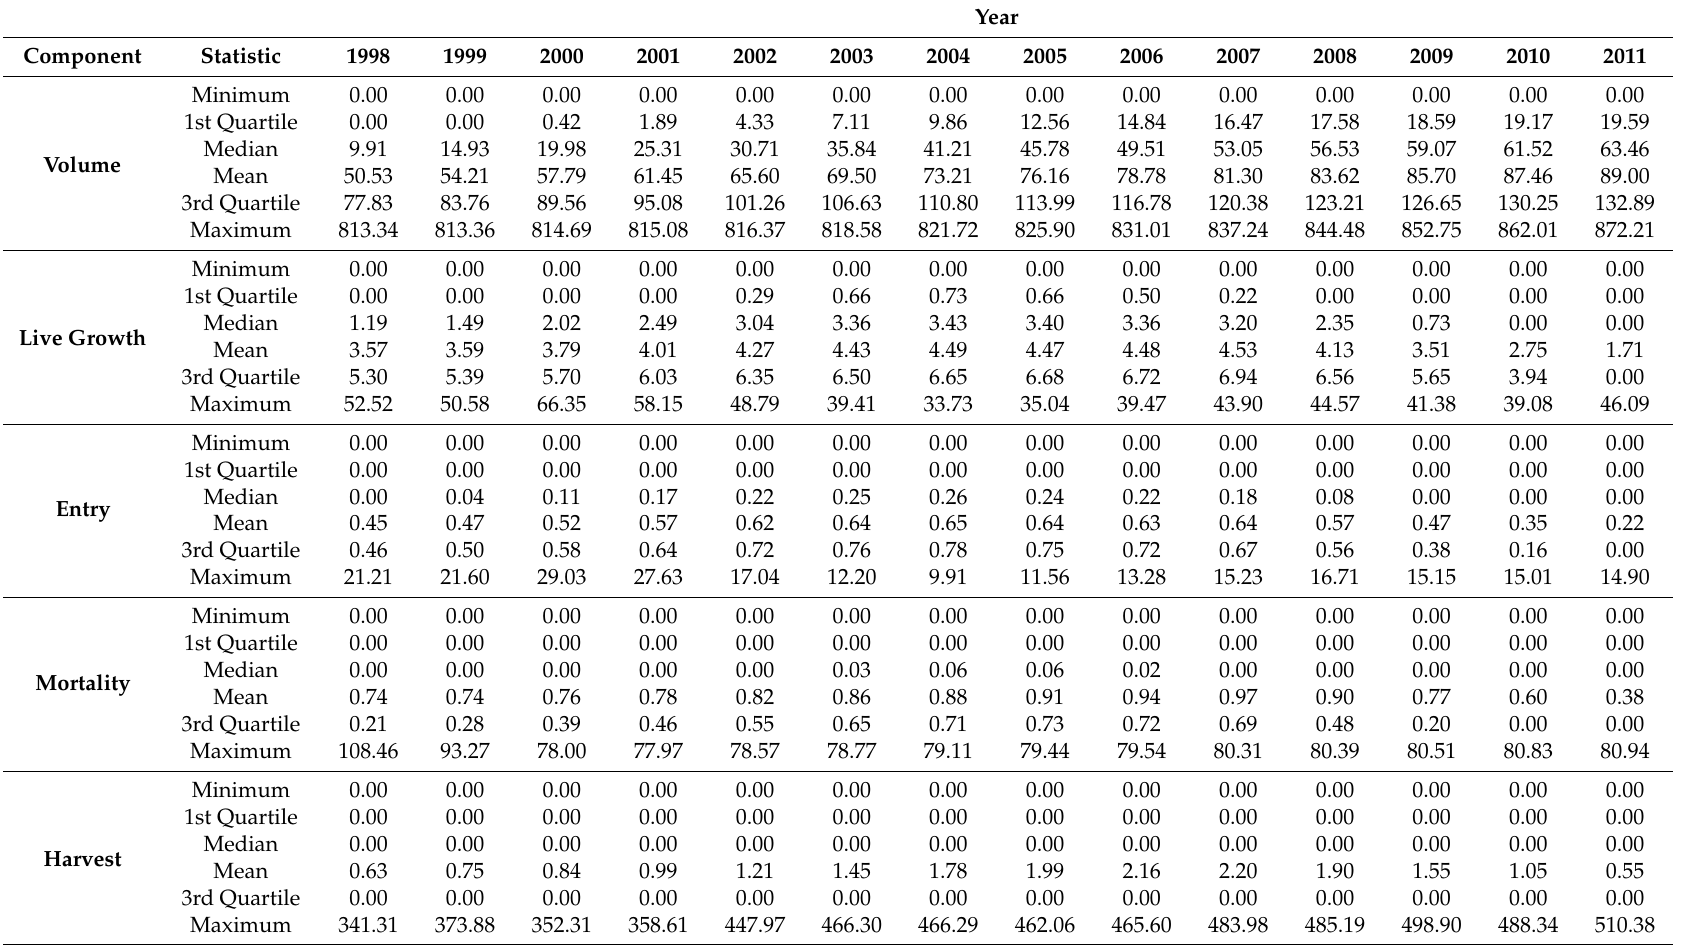
Table A1. Distribution statistics for population